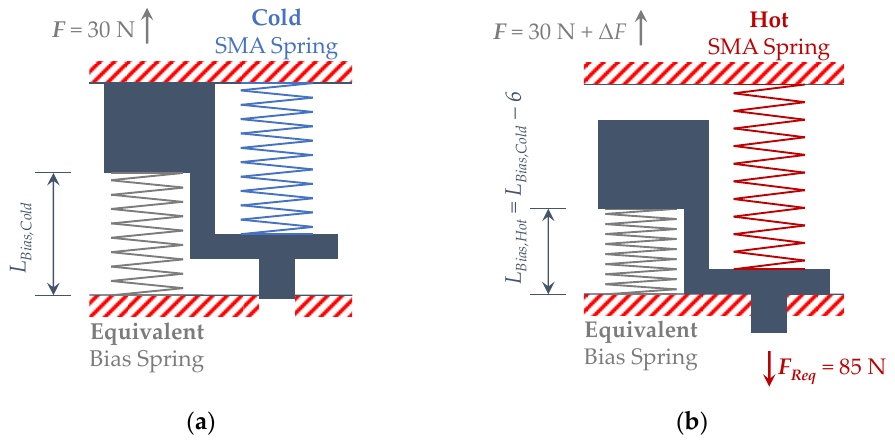
Figure 17. Operating scheme of the actuator (dimensions in mm). ( a ) Cold phase; ( b ) hot phase.